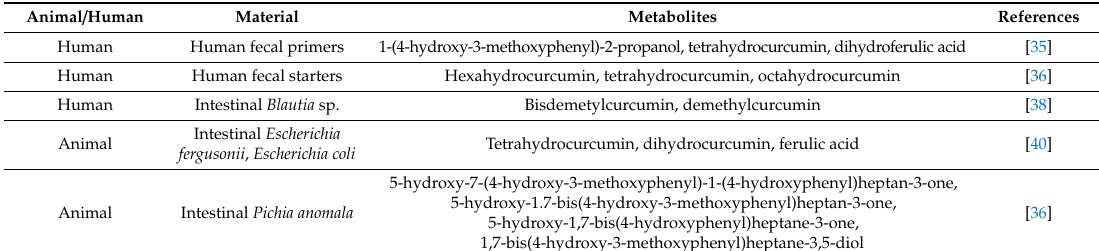
Table 2. The e ff ect of intestinal microflora on the production of curcumin metabolites. Animal / Human Material Metabolites